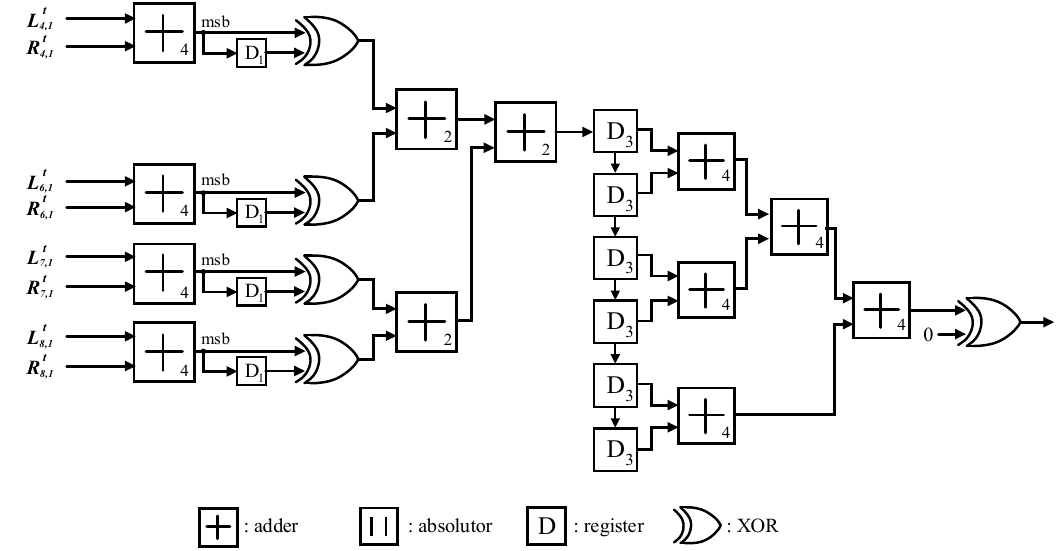
Figure 4. Hardware architecture of information-BER-based early-termination method [16] of (8, 4) polar codes.